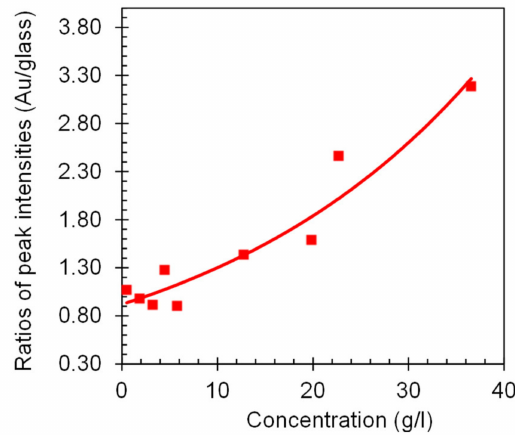
Figure 7. Ratios of the maximal emission intensities in HITC:PMMA films deposited on smooth Au films and on glass. The solid line is the fit of the data points with the second order polynomial—guide for